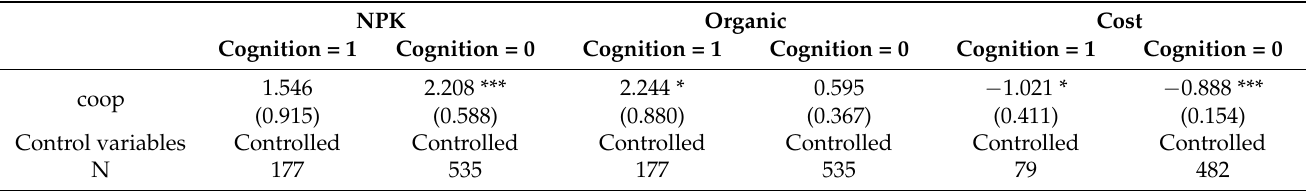
Table 6. Heterogeneity analysis of green perceptions of smallholder farmers’ fertilizer application reduction by joining